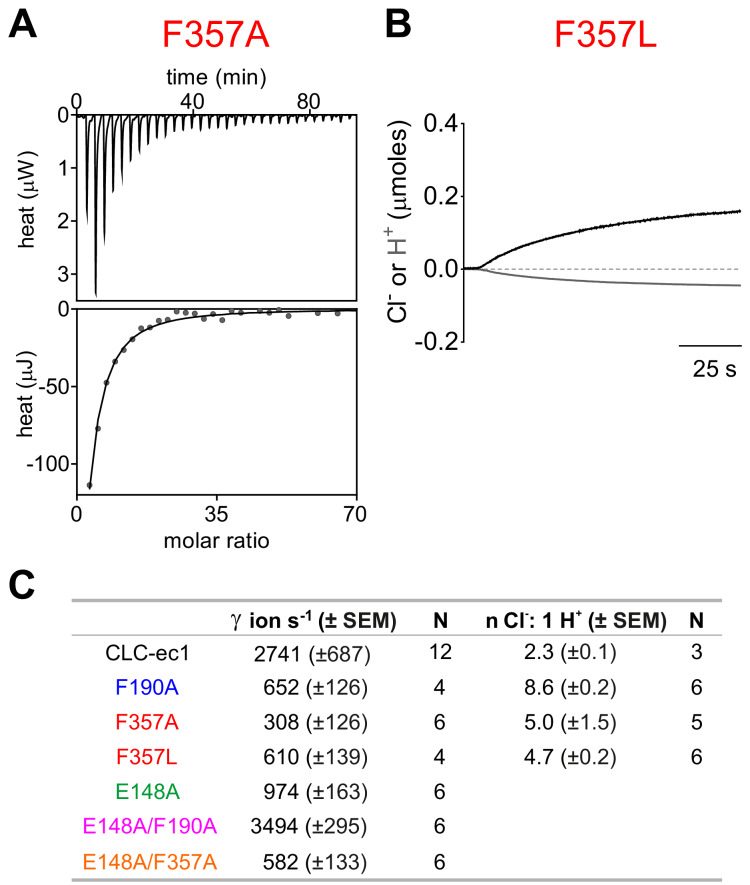
Effect of mutations on ion binding and transport in the CLC-ec1 exchanger.(A) Representative thermogram of Cl− binding to CLC-ec1 F357A. Top graphs show the heats released upon ion binding. Bottom graphs show the integrated heats (circles), and the solid line is the fit to a single-site isotherm with KD = 0.67 ± 0.02 mM; ΔH = −5.1 ± 0.3 kcal Mol−1, TΔS = −0.8 ± 0.3 kcal Mol−1, and n = 1 binding site, N = 2 independent repeats. (B) Representative time course of Cl- (black) and H+ (gray) transport recordings of purified CLC-ec1 F357L reconstituted into liposomes. (C) Summary table of transport rate and coupling stoichiometry for WT and mutant CLC-ec1. Numbers (N) of independent repeats of the flux measurements from at least two independent protein purifications.